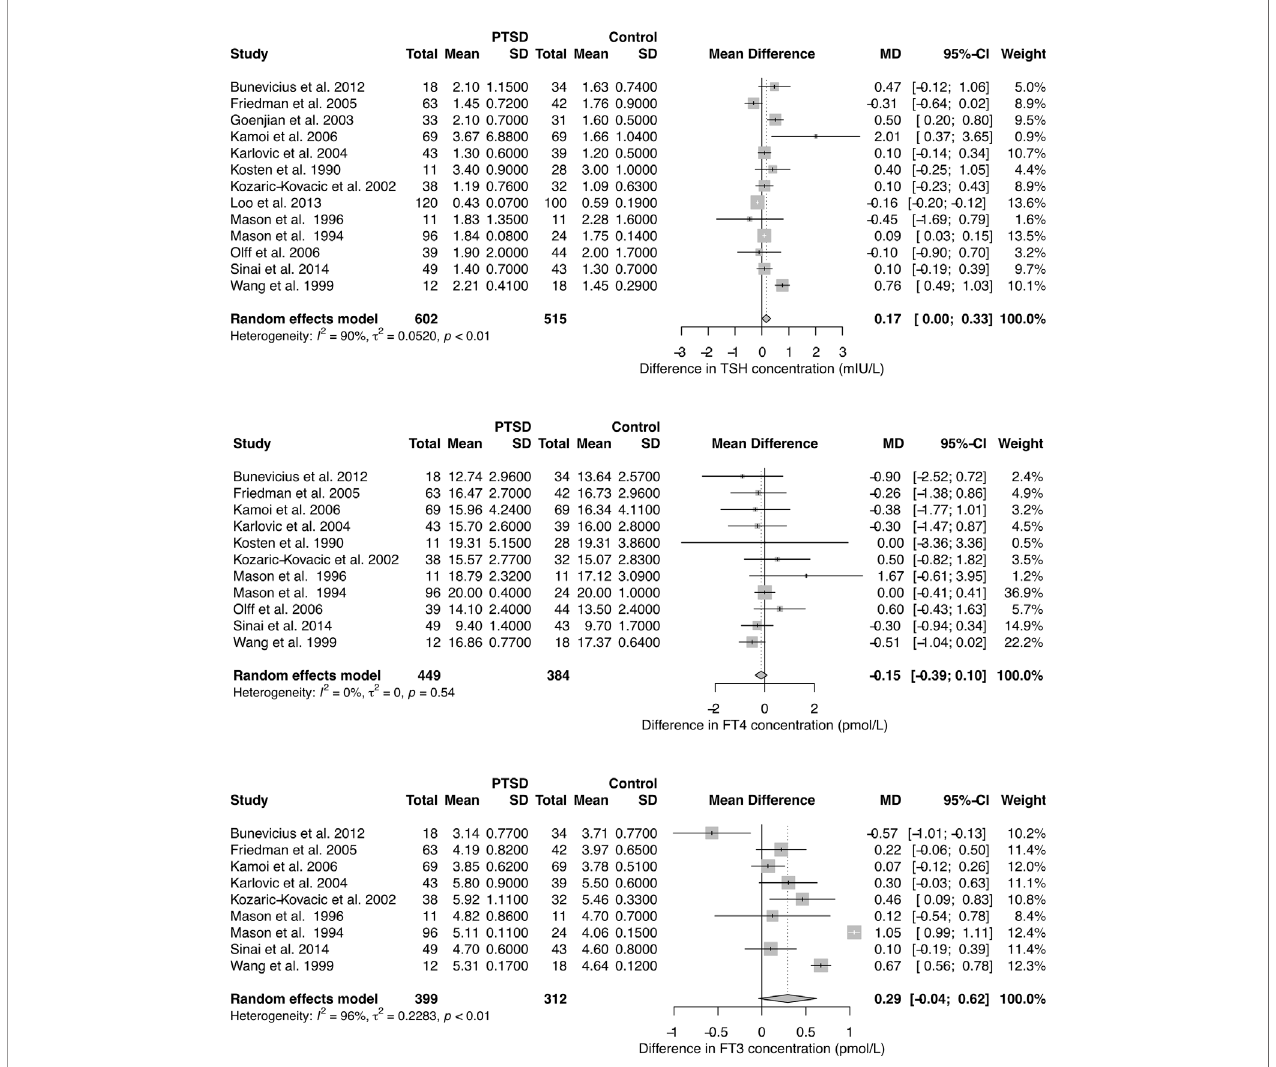
FIGURE 1 | Forest plots showing differences in TSH, FT4, and FT3 concentration between subjects with and without PTSD. See Supplementary Figures 3 – 5 for results in chronic PTSD and for total T3 (TT3) and total T4 (TT4)